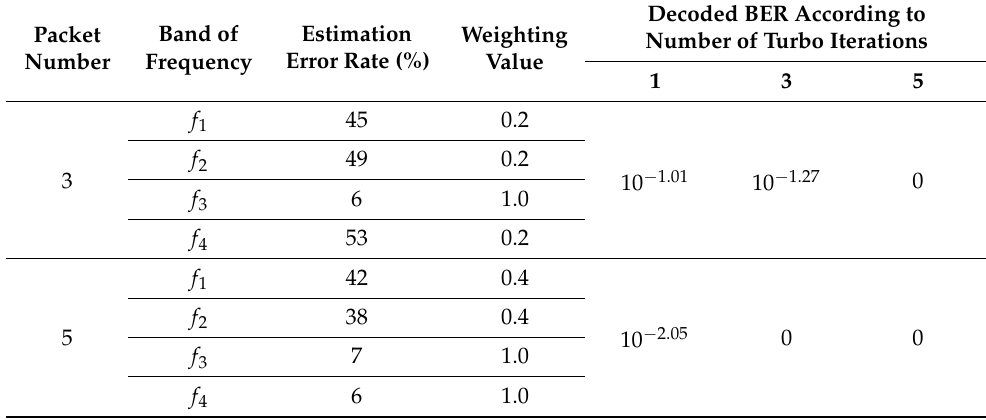
Table 5. Performance analysis according to weighting. ( N c = 32, N b =